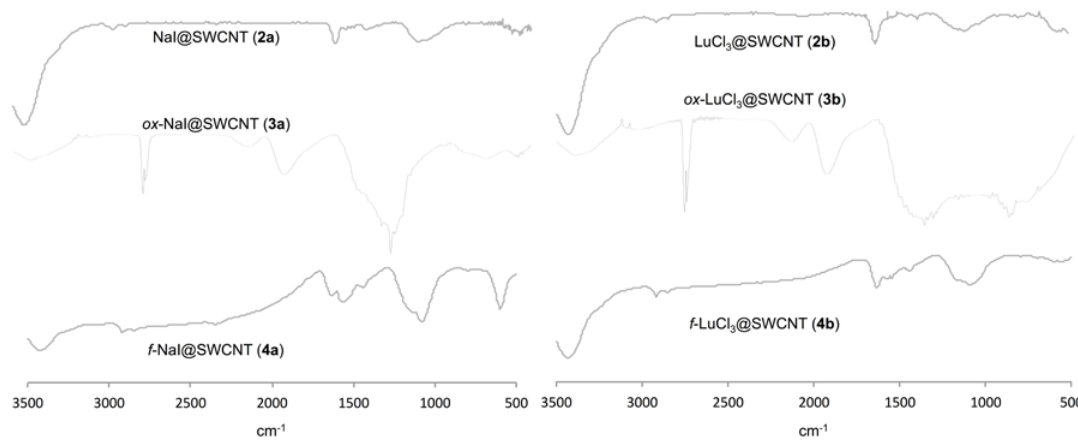
Figure 3 Figure 3. FT-IR spectra of MX@SWCNT 2 , ox -MX@SWCNT 3 , (light grey) and f -MX@SWCNT 4 .